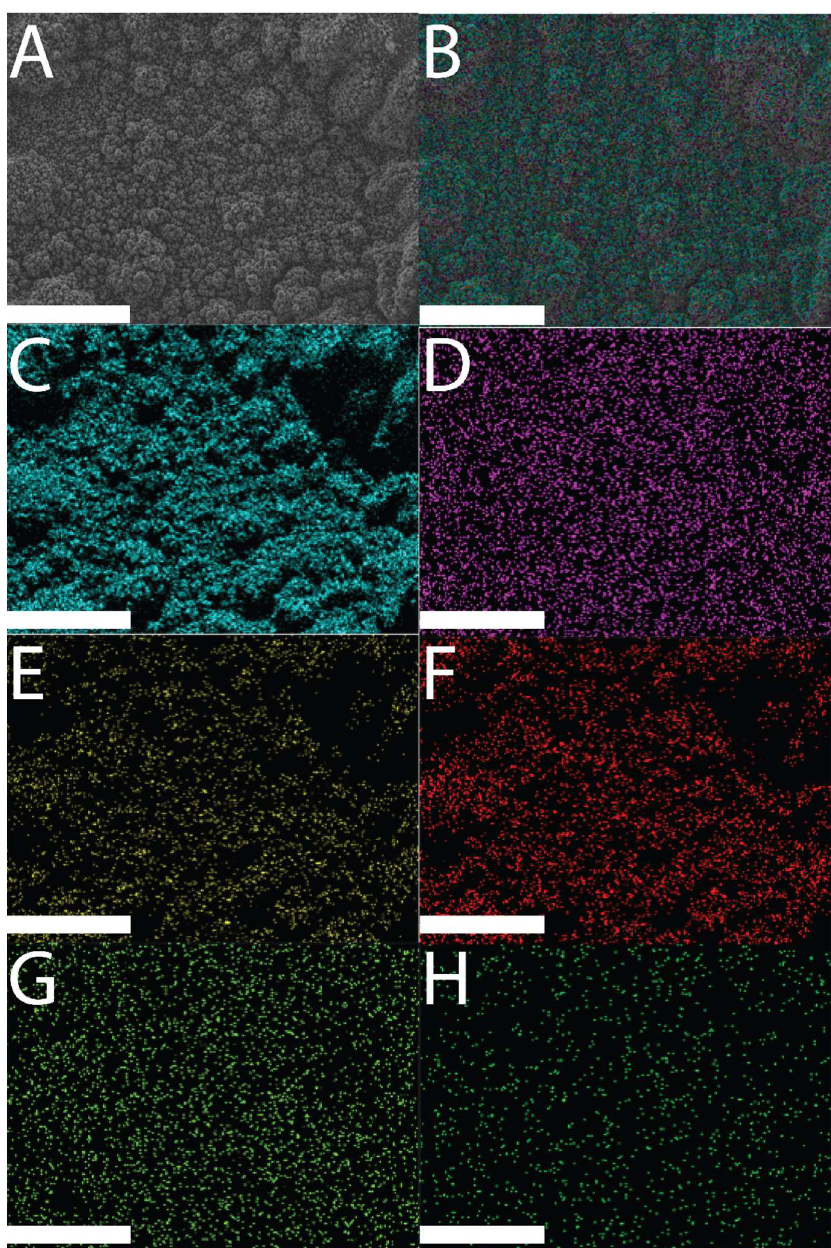
Figure 3. SEM and EDX images of an MER-doped PPY film: ( A ) SEM image of an MER-doped PPY film; ( B ) EDX layered image from an MER-doped PPY film; ( C ) Kα emission of C; ( D ) Kα emission of P; ( E ) Kα emission of F; ( F ) Kα emission of O; ( G ) Kα emission of N; ( H ) Kα emission of Si. Scale bars represent 100 µm.